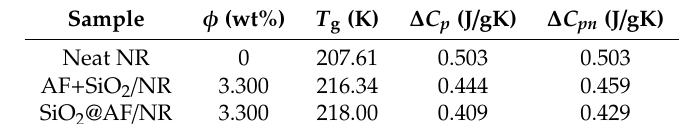
Table 2. Di ff erential scanning calorimetry (DSC) results for the glass transition of the neat NR and the NR composites.